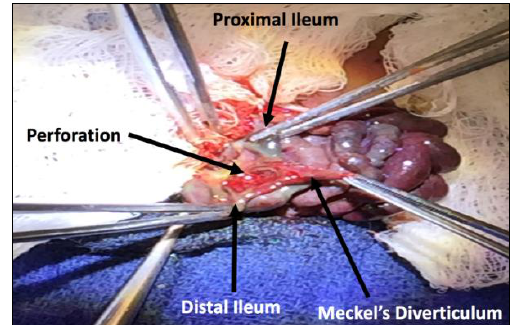
Figure 1: Perforated Meckel’s